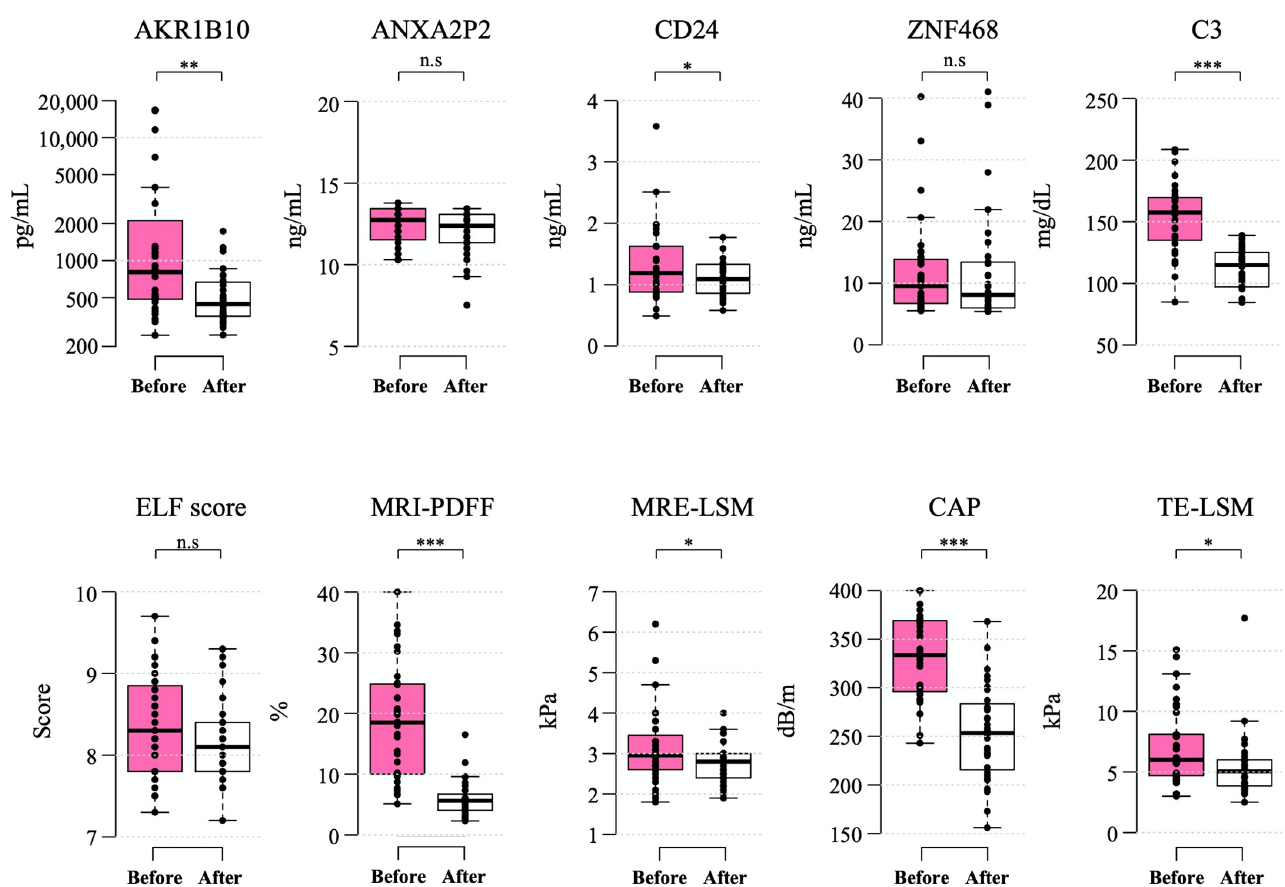
Figure 4. Changes in biomarkers 6–12 months after bariatric surgery. Box-whisker plots are shown, with the bottom and top of the box representing the 25th and 75th percentiles, respectively, and the middle line representing the median. The whiskers extend to the 5th and 95th percentiles, and outliers are presented as dots. *— p < 0.05; **— p < 0.01; ***— p < 0.001; and n.s.—not significant.